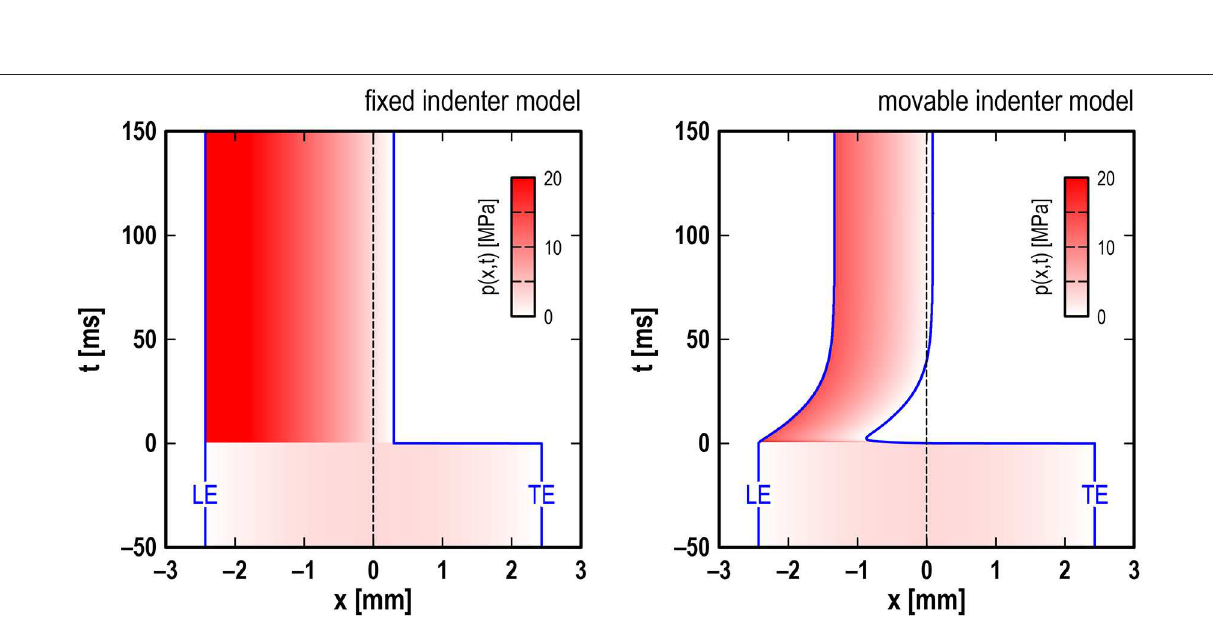
Frontiers in Mechanical Engineering |